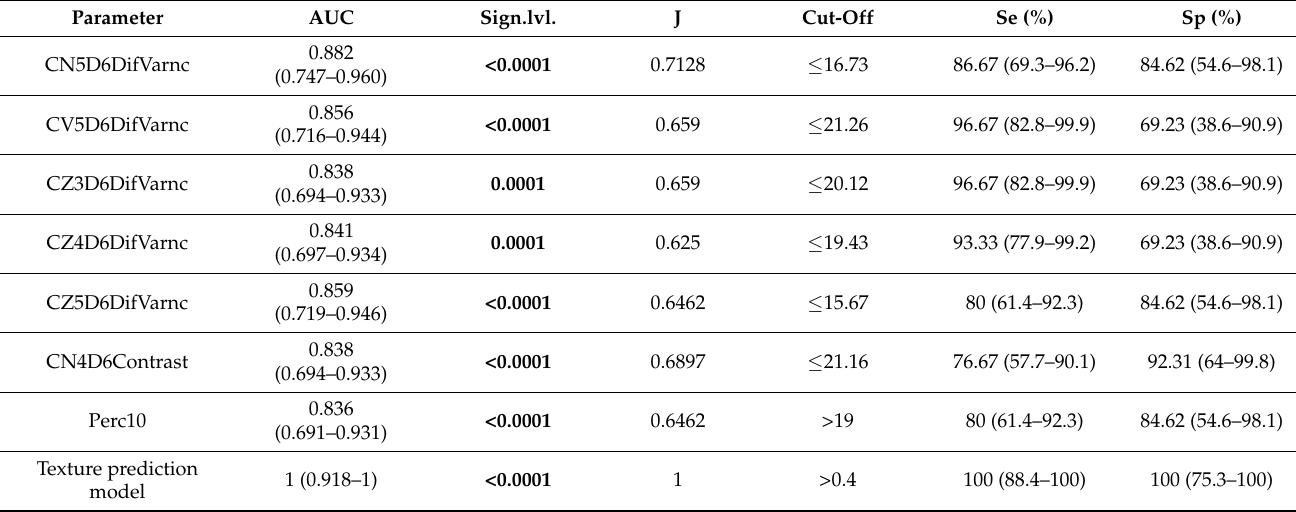
Table 6. The receiver operating characteristic analysis results of the prediction model and the texture parameters that were independently associated with endometriomas.